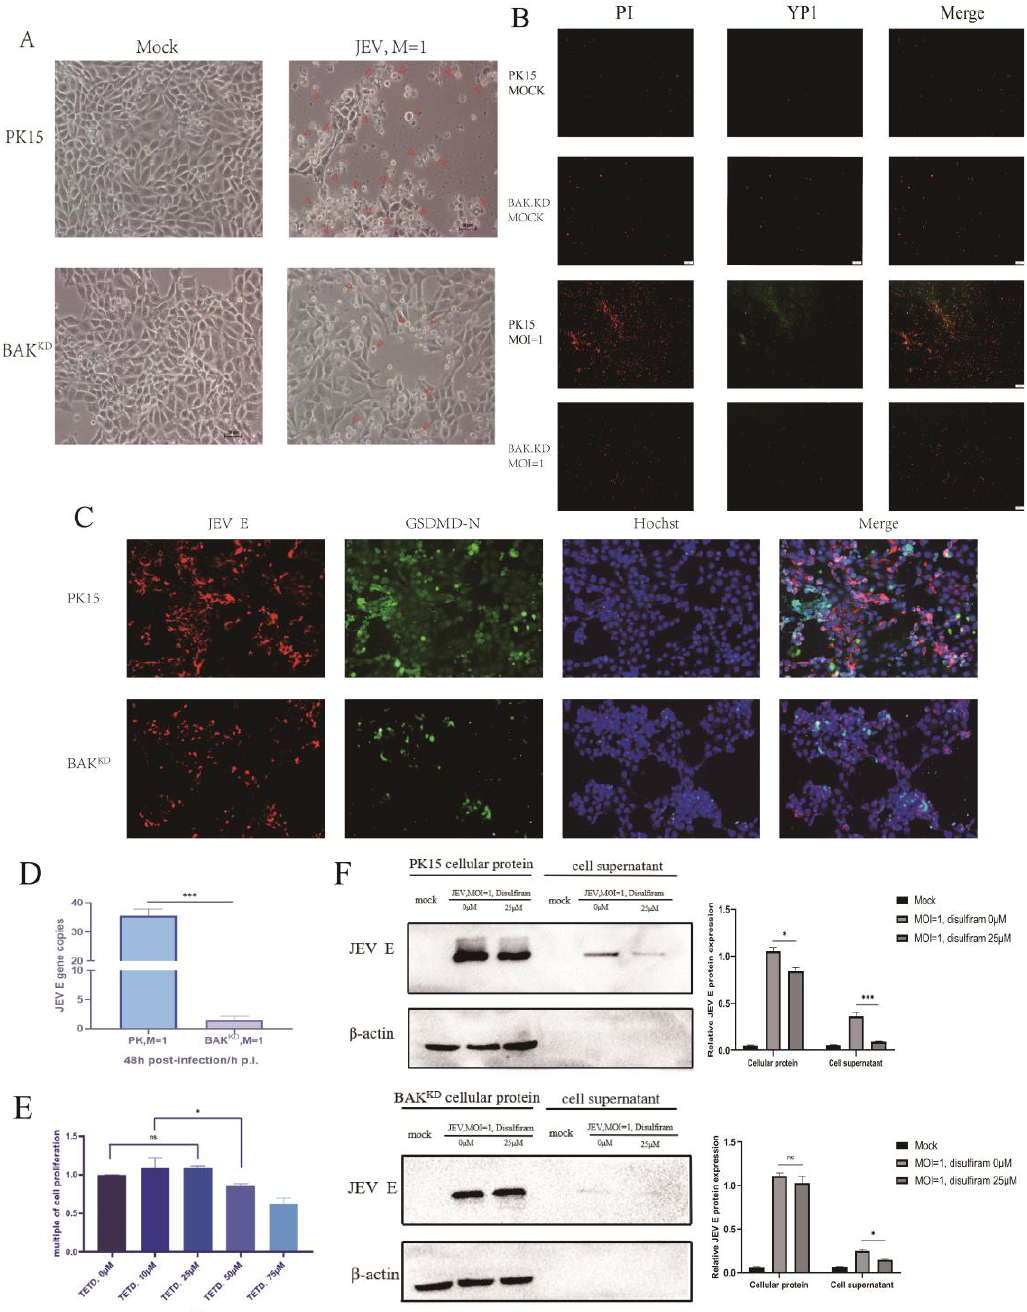
Figure 5. Activation of the pyroptotic pathway may promote the release of JEV. In this study, ( A ) 48 h after the JEV infection of cells, state changes in the cells were observed. The small arrows marked swollen cells, the damaged cell membrane, and the formation of intracellular bubbles. ( B ) The 12-well plate was plated with cell slides, and then the cells were added. When the cells reached 90%, the cells were infected with JEV MOI = 1 for 48 h. Afterwards, the cells were treated according to the fluorescence quantitative microscope observation method of the PI/YP1 apoptosis and necrosis detection kit and then observed under a fluorescence microscope. Red fluorescence indicated necrotic and apoptotic cells with damaged cell membranes, and green fluorescence indicated apoptotic cells with unbroken cell membranes. ( C ) Cells were incubated with a mouse anti-JEV E protein and rabbit anti-GSDMD-N at a dilution of 1:300 for 2 h, washed 3 times with PBST, and then incubated again